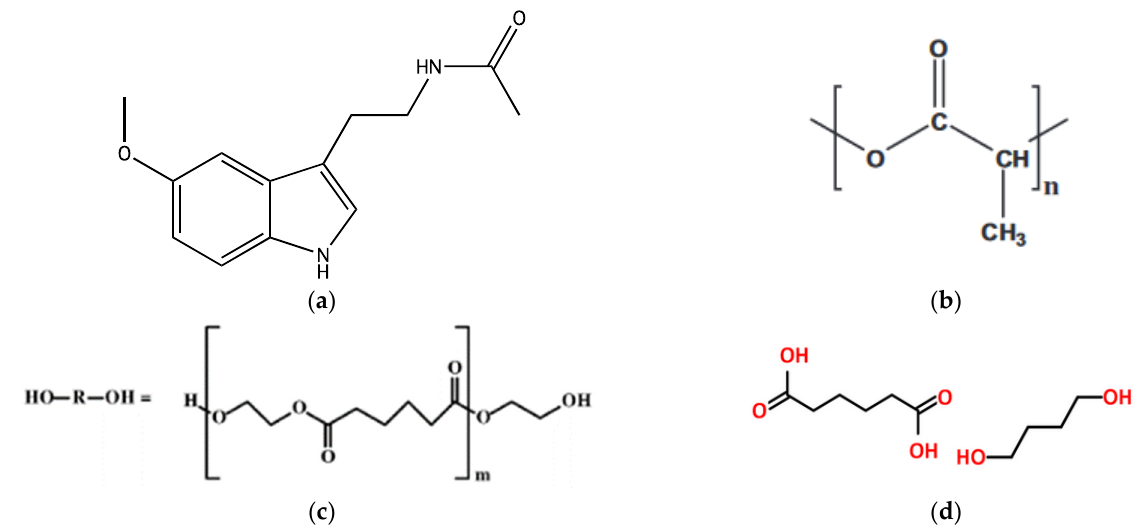
Figure 1. Chemical structures of ( a ) melatonin (MLT), ( b ) PLA, ( c ) poly(ethylene adipate) (PEAd), and ( d ) poly(butylene adipate)